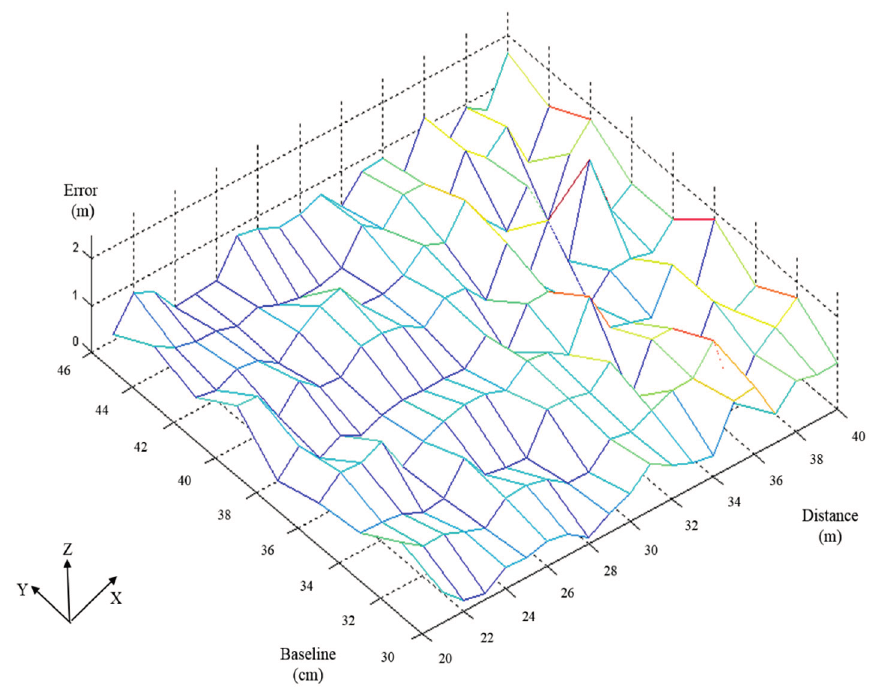
Figure 10. Error analysis of the calibration tables shown in Figure